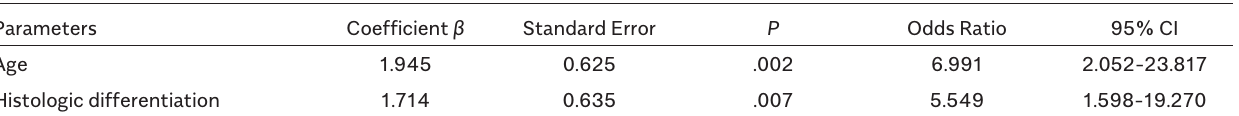
Table 5. Multivariate Analysis for Overall Survival